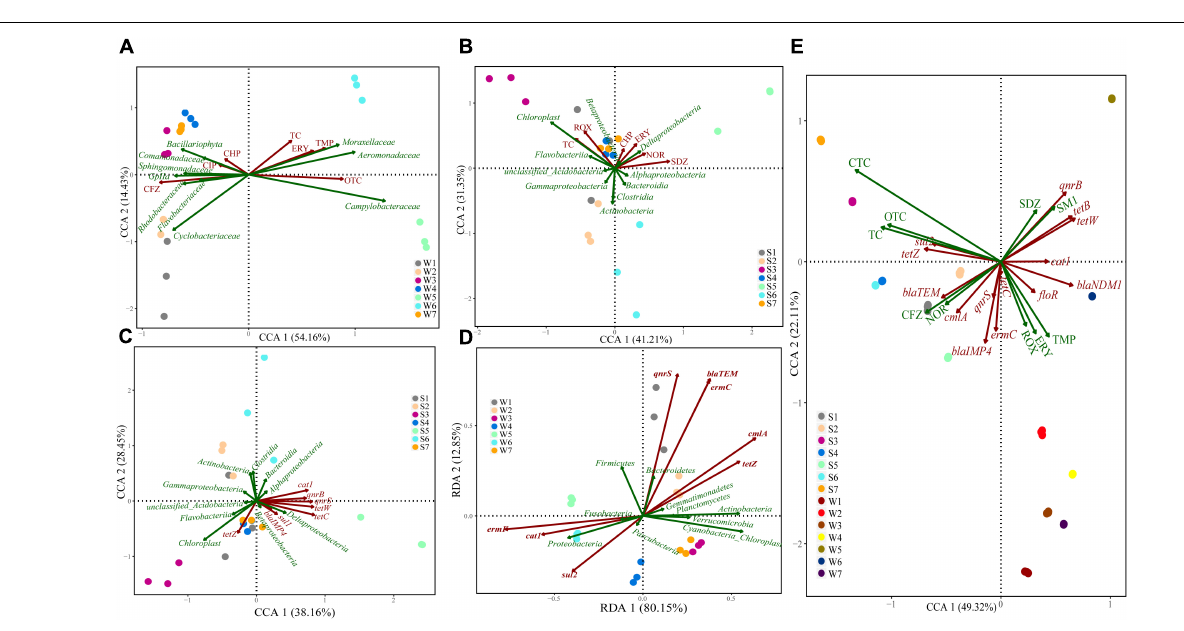
FIGURE 6 | Canonical correspondence or Redundancy analysis of the relationship between bacterial communities and antibiotics/ARGs distribution (A–D) , and the correlations among antibiotics abundance and ARGs distribution (E) . Samples are performed at different sites for three times in different color solid circles